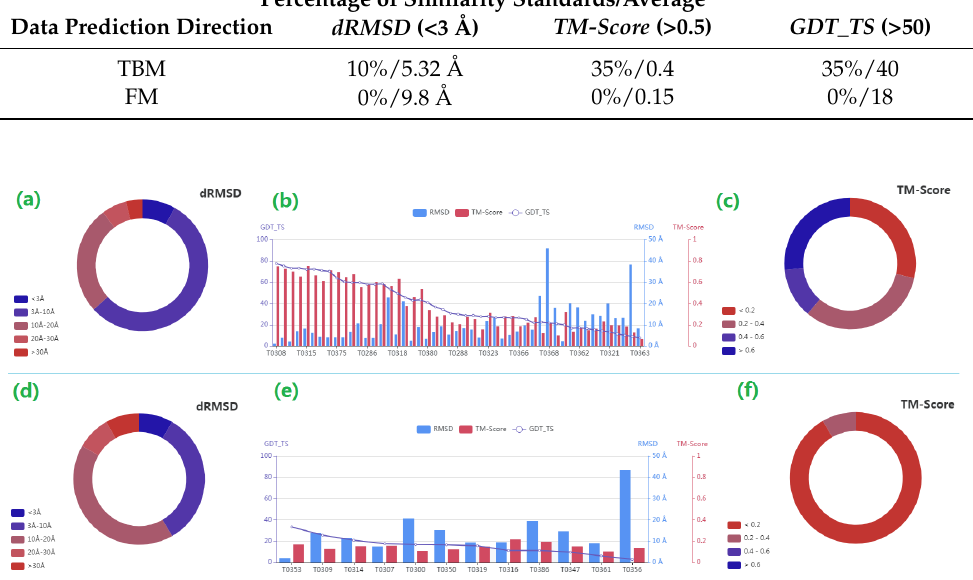
Figure 12. The prediction accuracy of the RGN. The charts ( a – c ) represent the prediction results of the RGN on the TBM data, and ( d – f ) represent the prediction results of the FM data. Pie charts ( a , d ) show the distribution of dRMSD , and pie charts ( c , f ) show the distribution of TM-Score . The mixed line and bar chart ( b , e ) show the comparison of GDT_TS and the other two evaluation